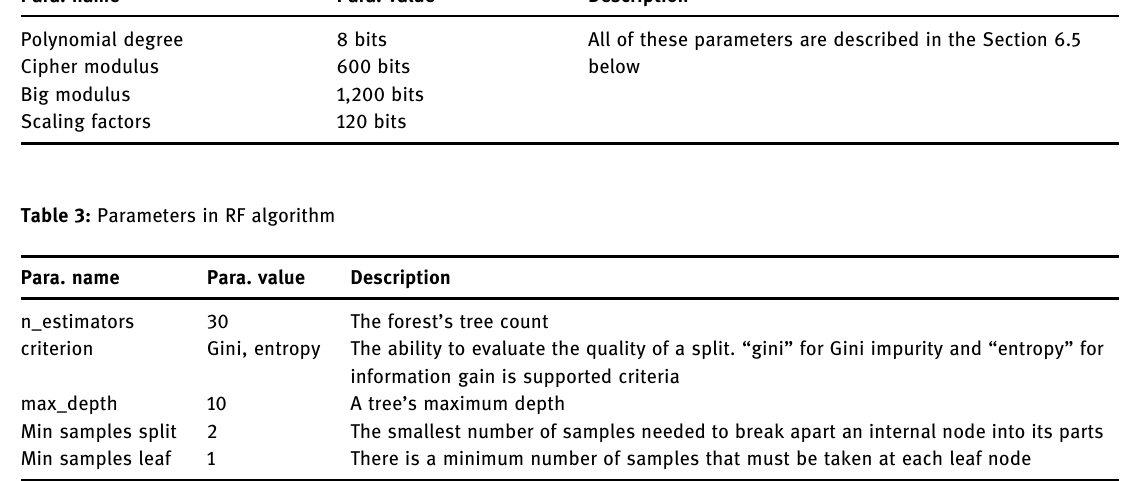
Table 2: Parameters in CKKS algorithm Para. name